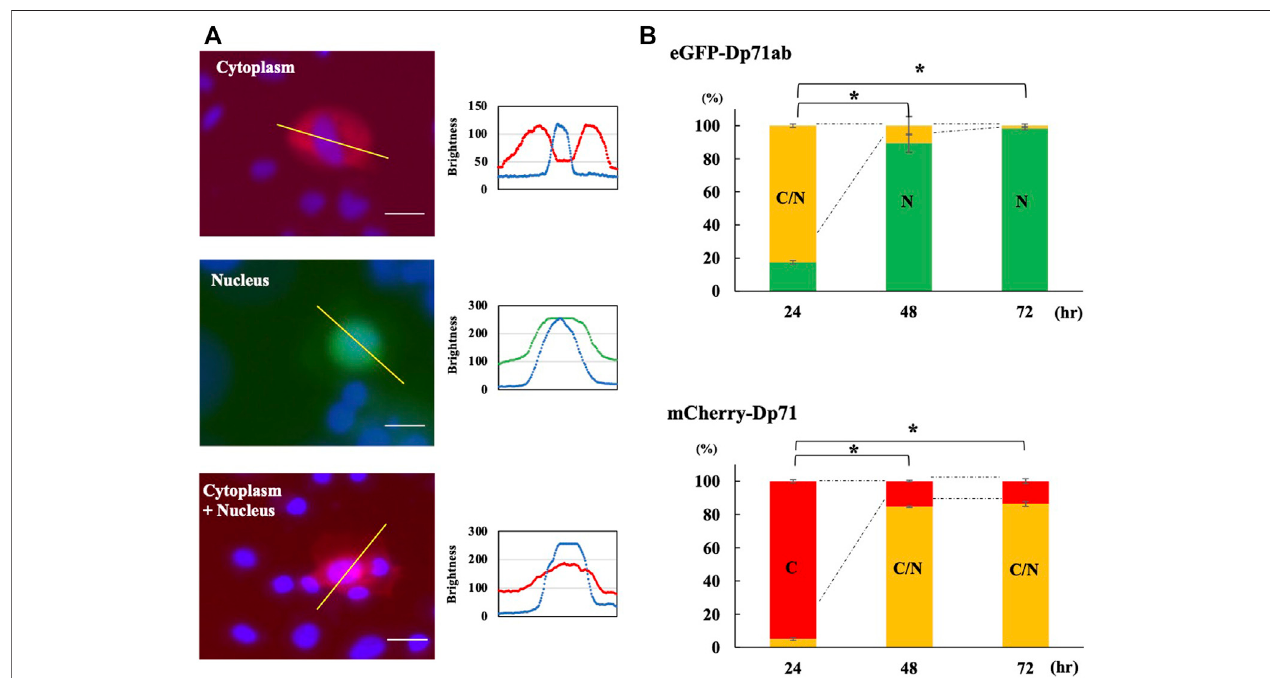
FIGURE 3 | Cellular localization of Dp71ab and Dp71 in myoblasts. eGFP-tagged Dp71ab and mCherry-tagged Dp71 were expressed in myoblasts, and fl uorescenceimagesofredmCherry-Dp71andgreeneGFP-Dp71awereobtainedat24,48and72 h.Thecellularlocalizationoftheexpressedproteinswasdetermined by visualizing the nucleus with Hoechst 33342 staining and classi fi ed into three groups: cytoplasm (C), cytoplasm + nucleus (cytoplasm/nucleus) (C/N) and nucleus (N). Representative images of the three groups of cellular localization (left of each group) and sagittal section (right of each group) results are shown (A) . In the cytoplasmic group, mCherry-Dp71 was present in the cytoplasm, leaving the nucleus open (left). The distribution of signals along the bar in the top fi gure is shown (bottom). A red signal was present, avoiding the nucleus (blue signal). In the nuclear group, green eGFP-tagged Dp71ab was present in the nucleus (middle). In the cytoplasm/nucleusgroup,mCherry-Dp71waspresentinboththecytosolandnucleus(right).Thepercentagesofcellsclassi fi edintothethreegroupswerecalculatedat 24, 48 and 72 h and are shown as bars (B) . At 24 h, 94.9% of the myoblasts transfected with Dp71 belonged to the cytoplasm group. In contrast, 82.5% of the myoblasts transfected with Dp71ab belonged to the cytoplasm/nucleus group. At 72 h, 86.3% of the myoblasts transfected with Dp71 belonged to the cytoplasm/ nucleus group. In contrast, 98.4% of the myoblasts transfected with Dp71ab belonged to the nucleus group. The percentage of the major group at 24 h showed signi fi cant changes at 48 and 72 h * = p < 0.001 compared with the major group at 24